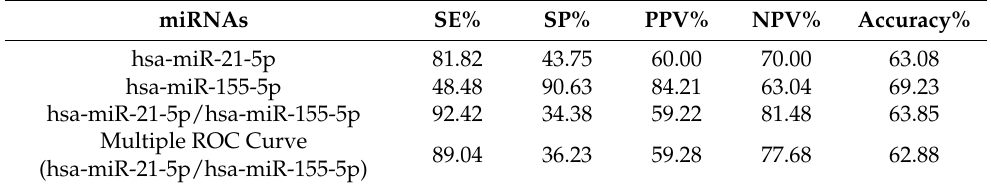
Table 3. Performance of miRNAs as biomarkers for identification of early stages Renal Cell Carcinomas.